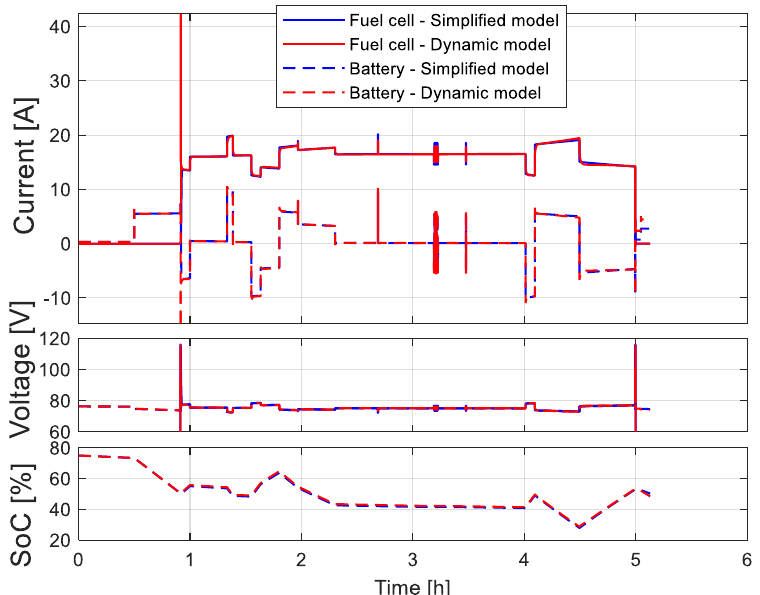
Figure 7. Simulation of a HT-PEM fuel cell–battery LFP direct hybridization on an aeronautical mission with simplified and dynamic models.